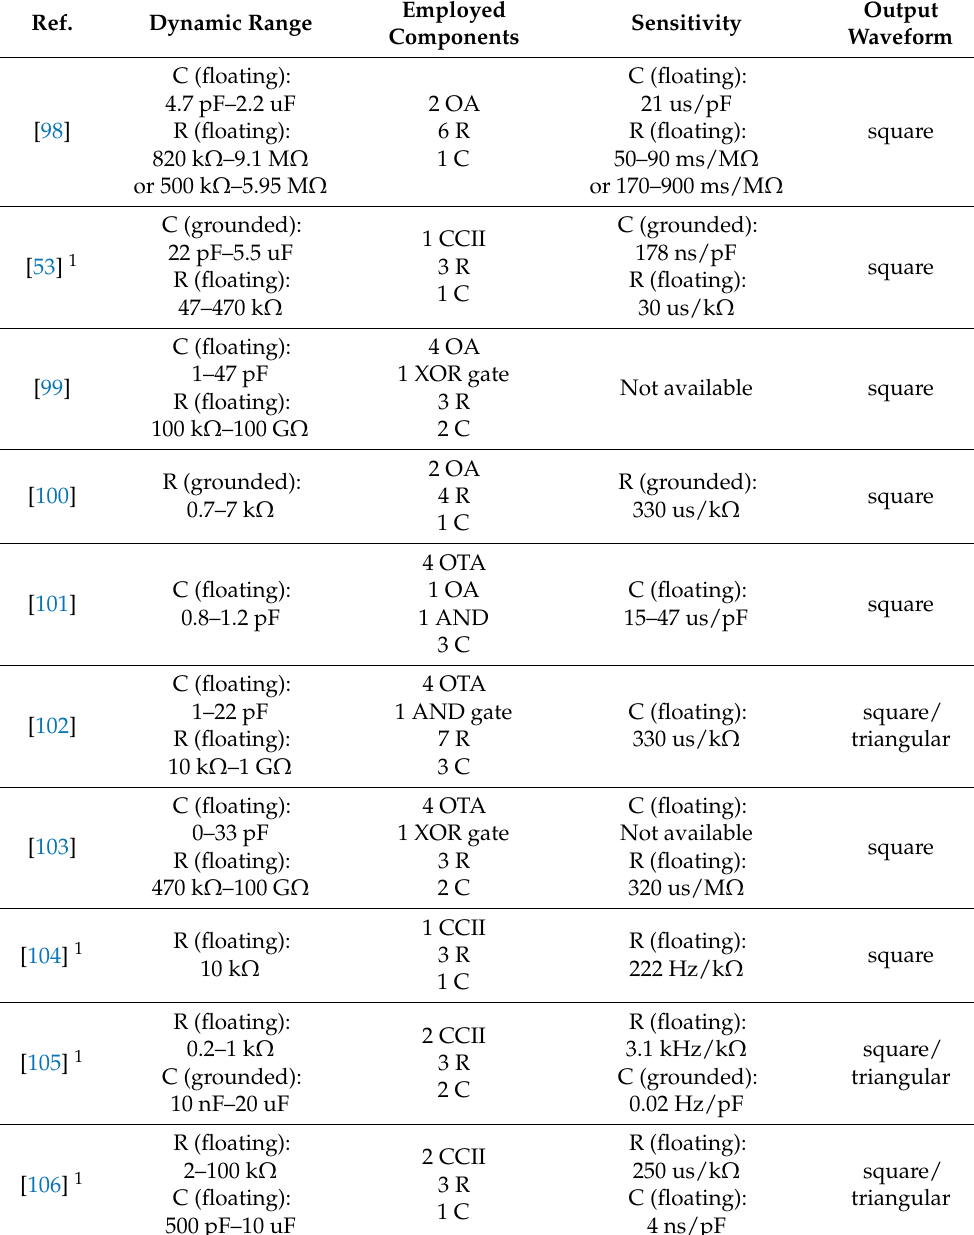
Table 1. Comparison between some current-mode oscillator-based read-out circuits and conventional voltage-mode